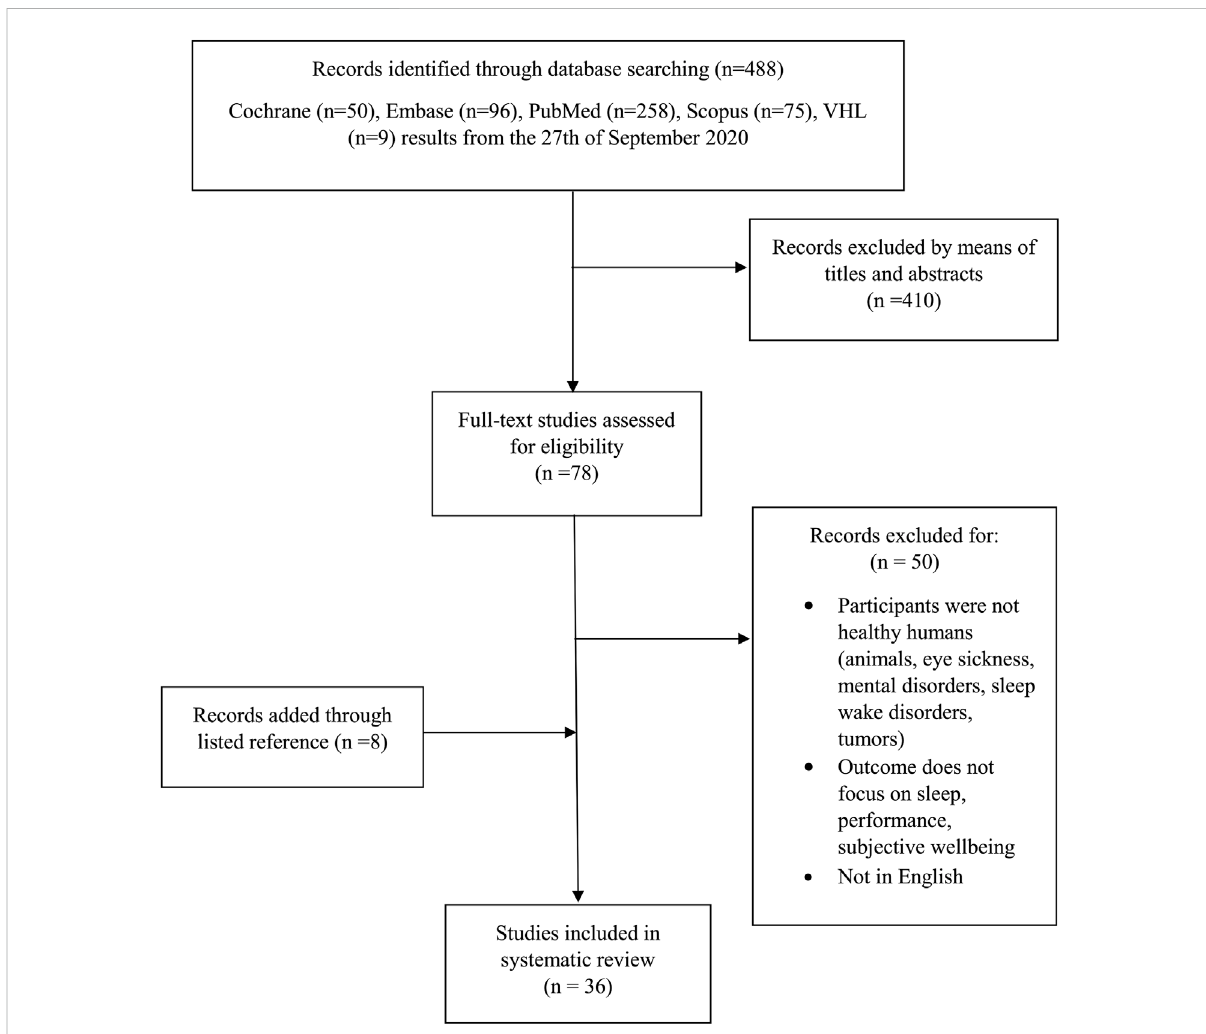
FIGURE 1 Selection process for research articles included in the review. Modi fi ed version from the recommendation in the PRISMA (Preferred Reporting Items for Systematic Reviews and Meta-Analyses) statement Moher et al. (2015). Legend: Virtual Health Library